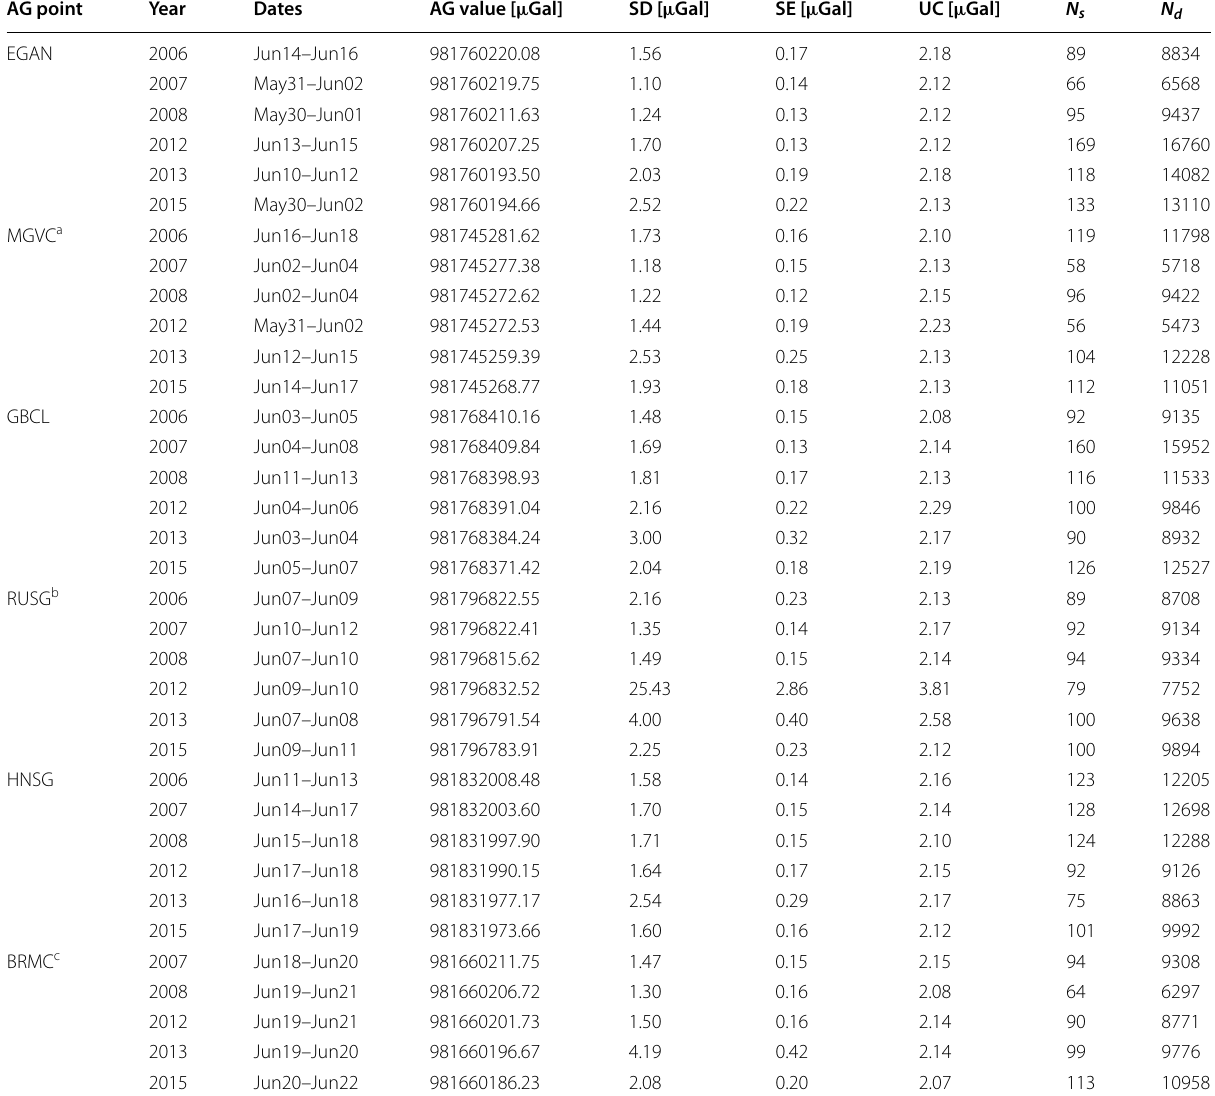
Table 2 Reprocessed AG at gravity points in